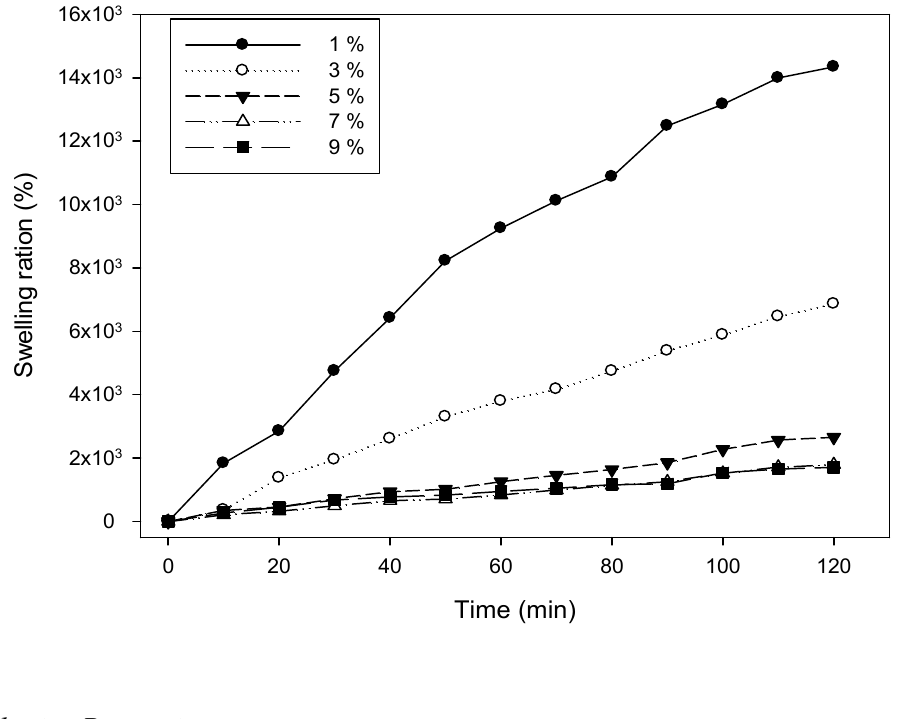
Figure 3. Effect of irradiation dose on the swell percent of the crosslinked poly(acrylic